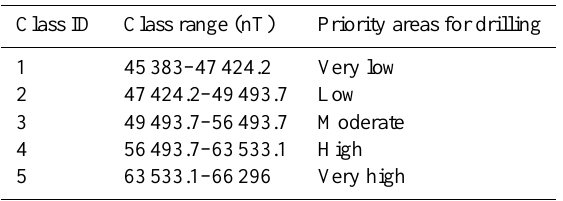
Table 1. RTP classification of magnetic anomalies based on the fractal method.